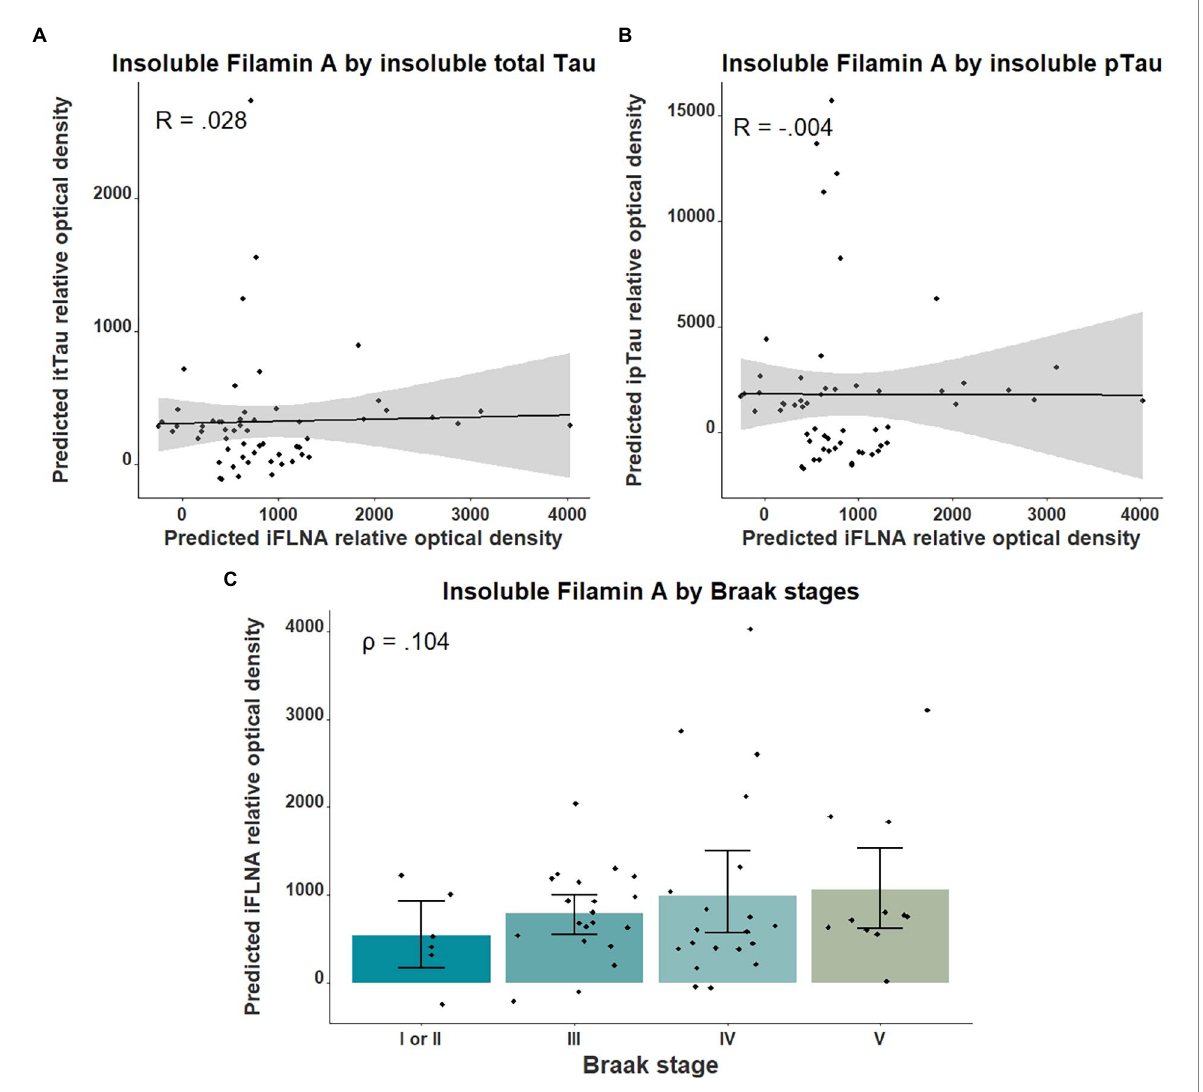
FIGURE 3 Associations between insoluble FLNA and tau-derived metrics. Insoluble FLNA (iFLNA) levels were not significantly associated with either insoluble total tau [itTau; (A) ], insoluble phosphorylated tau [ipTau; (B) ] and Braak stages (C) . Predicted insoluble FLNA, itTau, and ipTau values shown were calculated by adding the mean to the residual values from age, sex, and study batch linear regression. Standardized beta and rho values are used to display the strength of